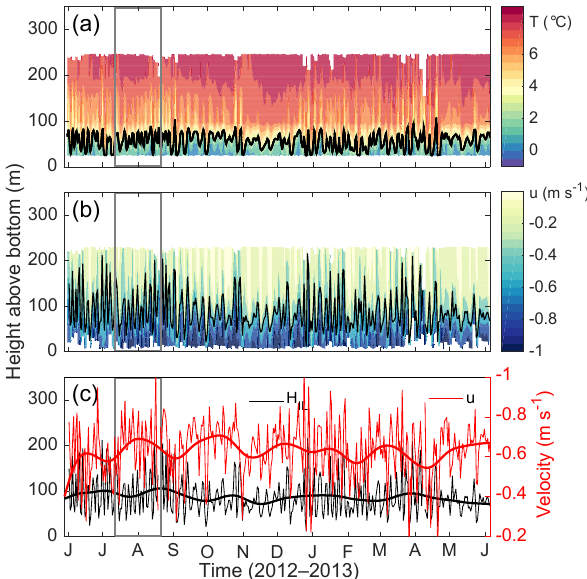
Figure 6. As Fig. 5 but for mooring S2. The grey boxes mark the time period shown in Fig. 11.